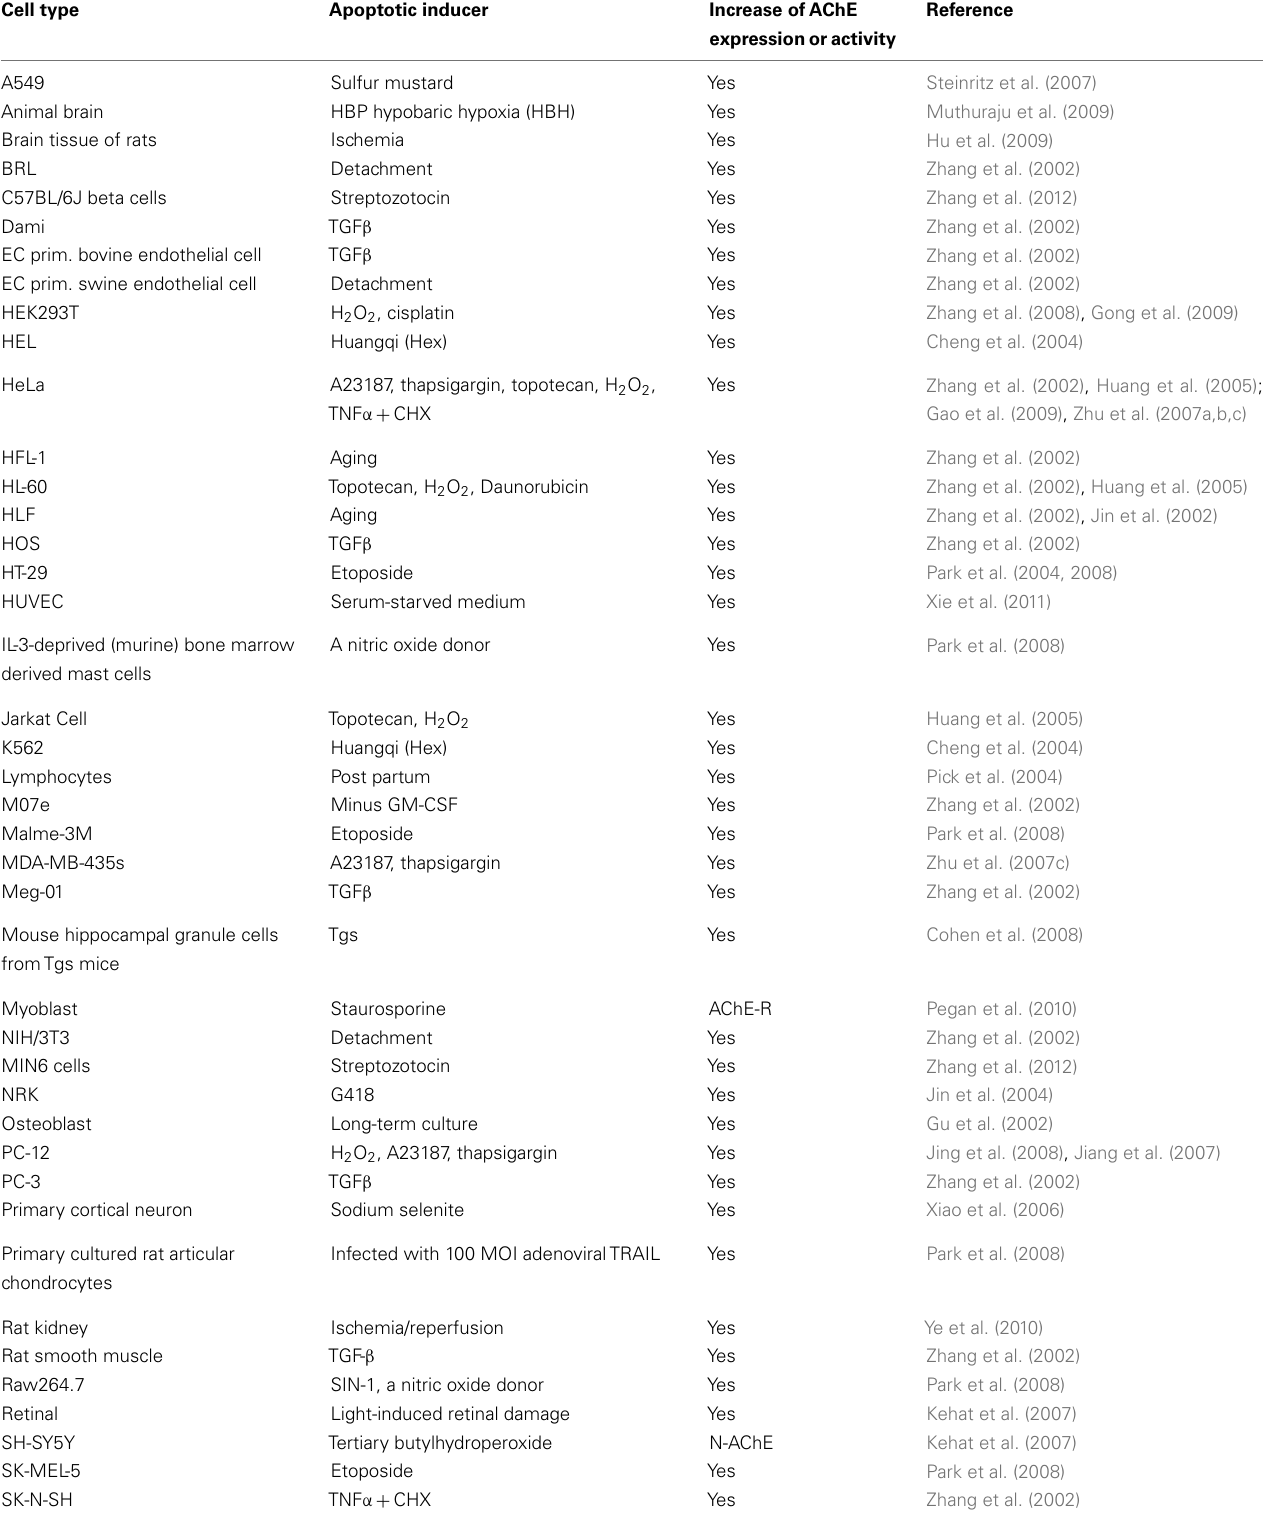
Table 1 | Summarized cell lines in whichAChE expression or activity were increased by the apoptotic stimuli with various apoptotic